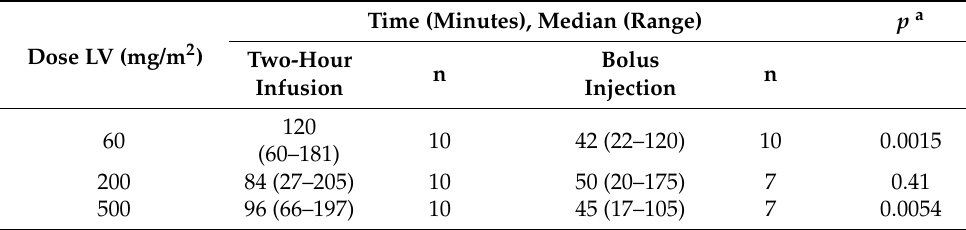
Table 3. Ischemic time by LV administration